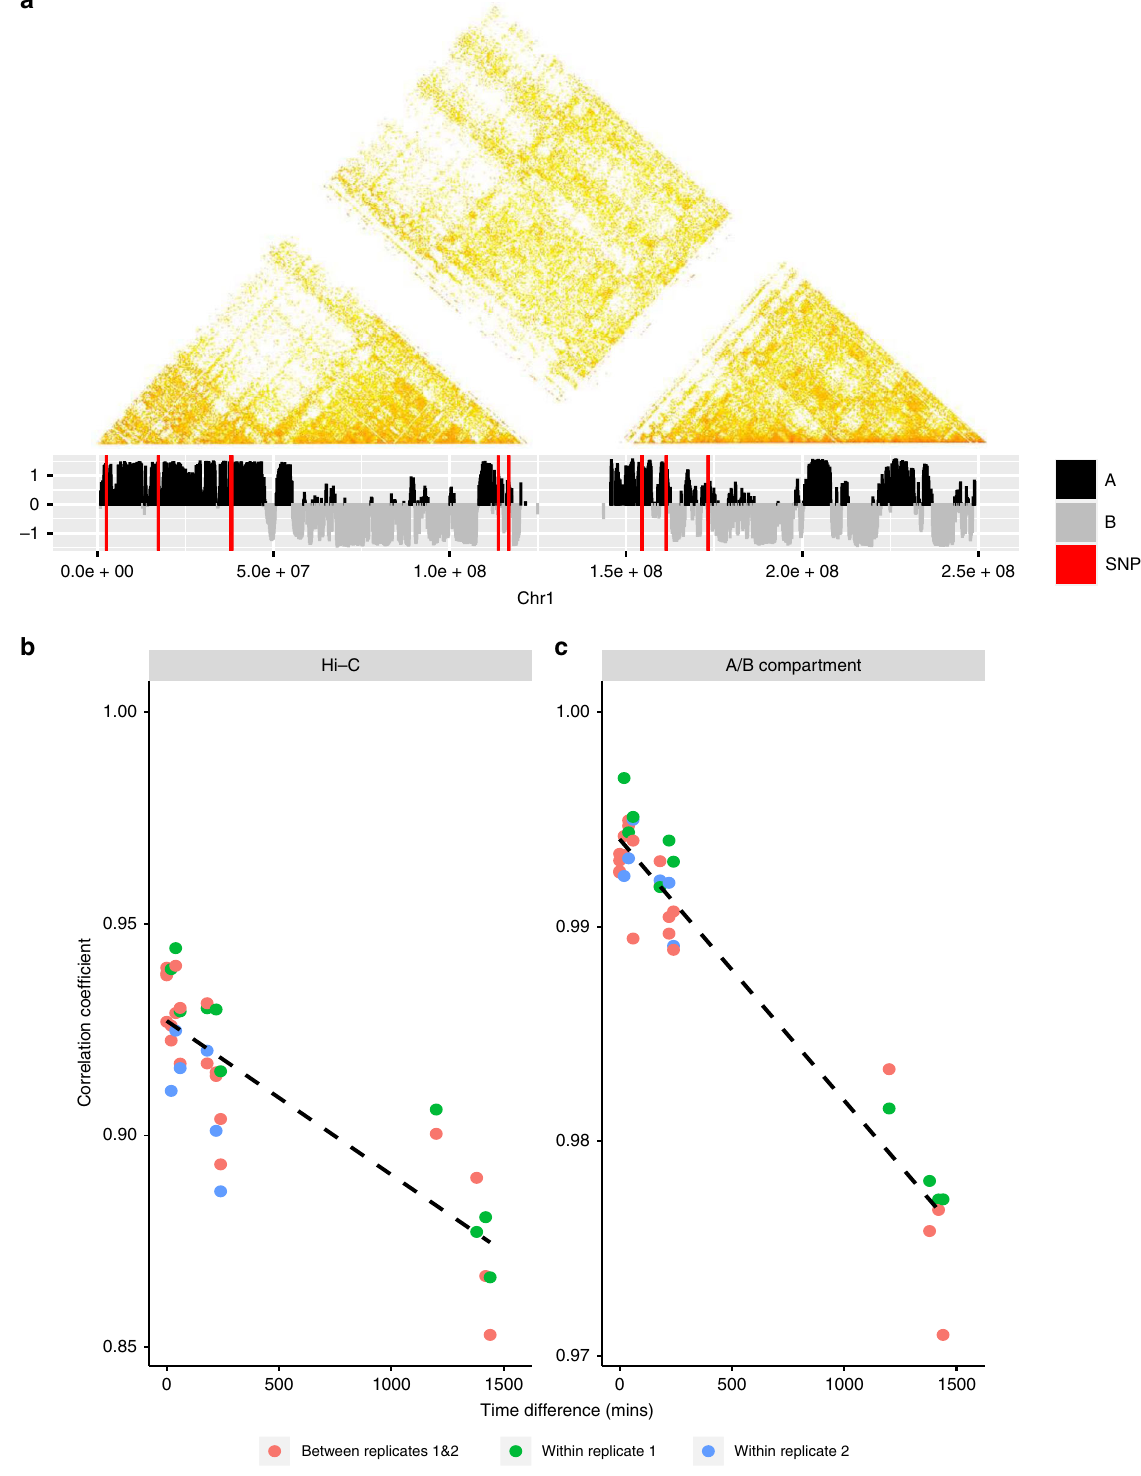
Fig. 2 Illustration of Hi-C dynamics. a Hi-C interaction matrix (100 kb resolution) of replicate 1 for chr1 at time 0 min (upper) with corresponding A/B compartments (lower), where red lines represent positions of SNPs. b Correlation changes between Hi-C data with respect to differences between times, where the dashed line is the fi tted linear line for the correlation coef fi cients. c Correlation changes of A/B compartments with respect to the differences between times, where the dashed line shares the same information as conveyed in the plot